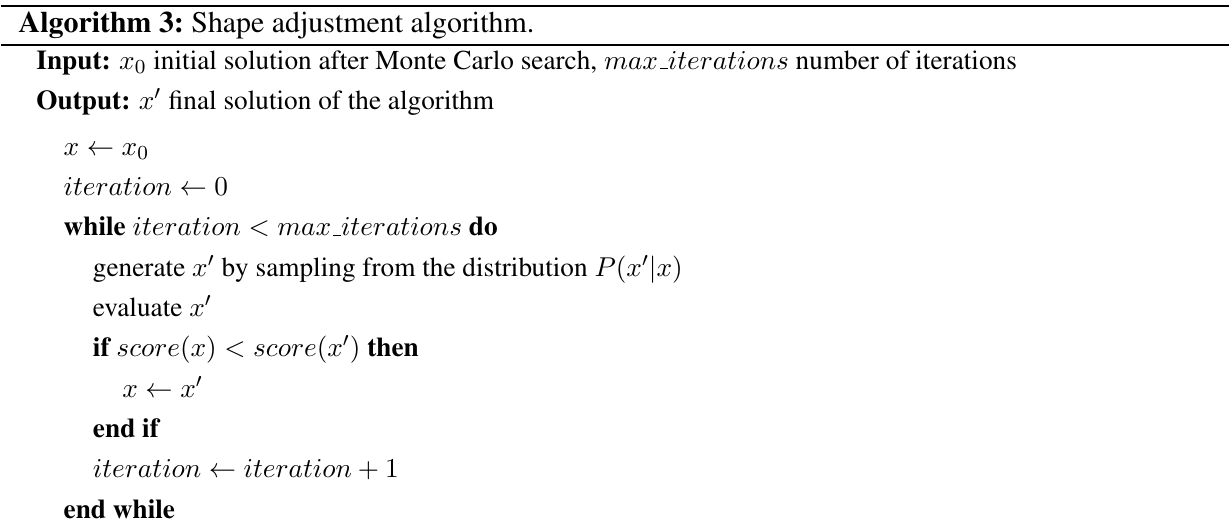
Algorithm 3: Shape adjustment